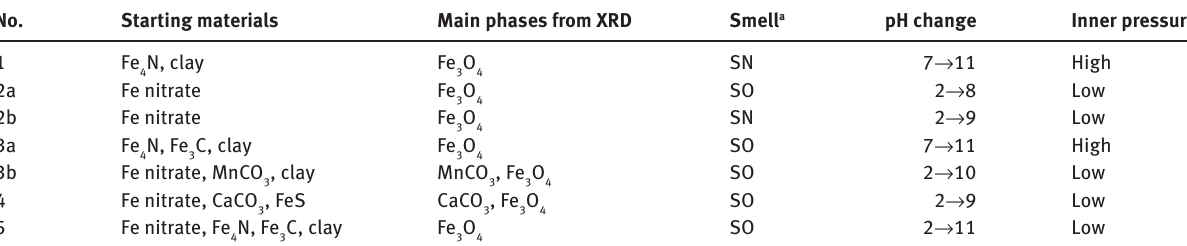
Table 2: Summary of experimental results. No. Starting materials